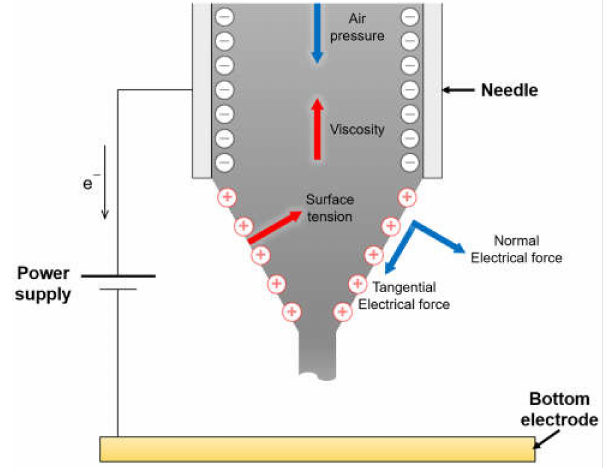
Figure 2. Schematic diagram of the force balance between pneumatic force, viscosity, surface tension, and electrical force during electro-hydrodynamic jetting.